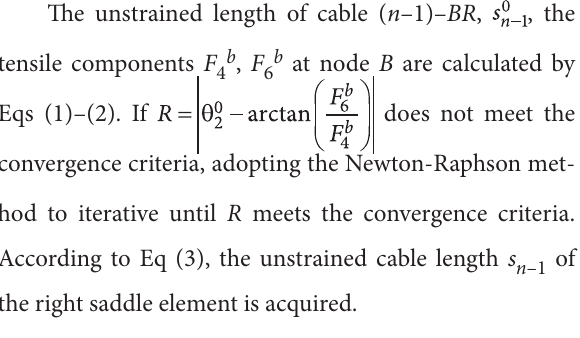
Fig. 3. The analysis of the main